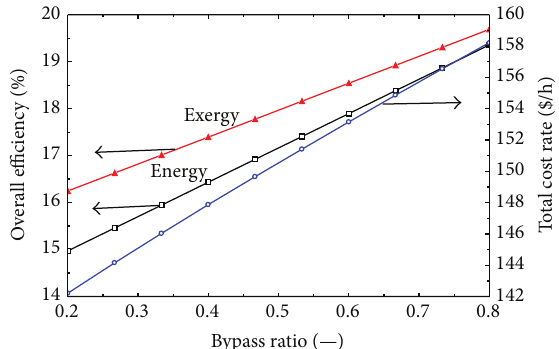
Figure 11: The impact of the bypass ration on the objective functions.